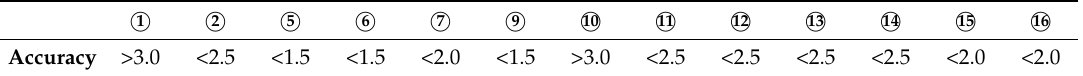
Table 3. Location accuracy of gravity matching in various regions of China Western Pacific area (unit: n